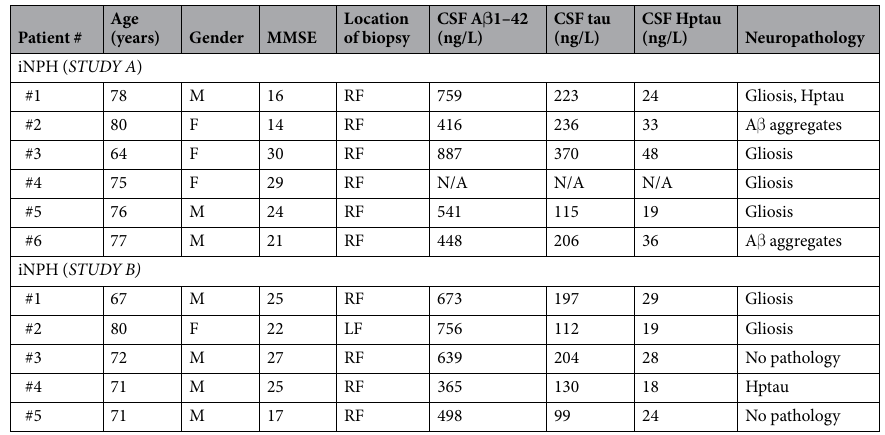
Table 2. Patient characteristics in the evaluated cohorts of idiopathic normal pressure hydrocephalus (iNPH) patients. Reference interval: CSF-A β 1-42 > 550 ng/L, CSF-Tau < 400 ng/L, CSF-HPtau-tau < 80 ng/L, M = male; F = female; RF = right frontal; LF = left frontal; N/A = not established; MMSE = preoperative mini-mental